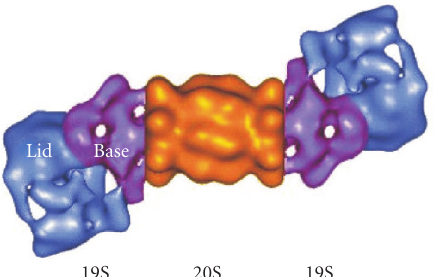
Figure 4: The structure of the 26S proteasome complex. (http:// www.biw.kuleuven.be/dtp/cmpg/pgprb.htm.)